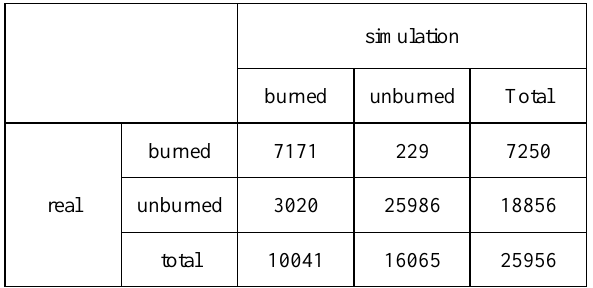
Table 4. Reading error matrix from comparing actual fire data